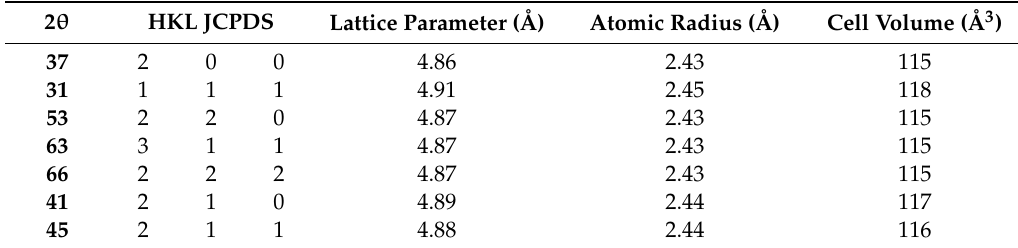
Table 1. X-ray di ff raction calculated ZnO 2 crystal structure parameters.